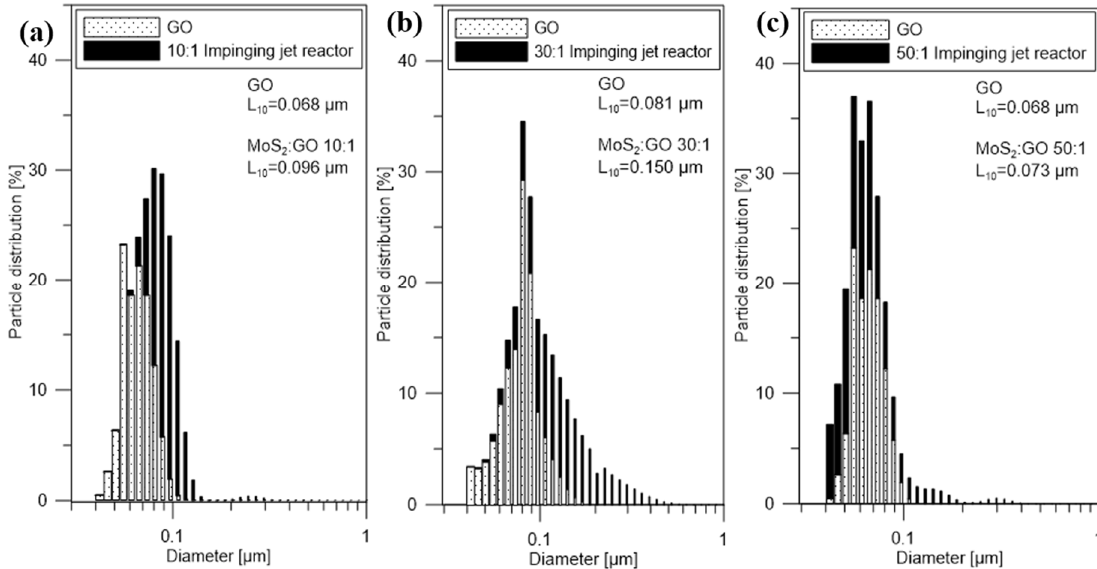
Figure 4. Particle size distribution profiles by number of particles of direct products of the reaction in the impinging jet reactor for MoS 2 /GO ratio ( a ) 10:1 ( b ) 30:1 ( c ) 50:1 and GO just before the reaction. the impinging jet reactor for MoS 2 / GO ratio ( a ) 10:1 ( b ) 30:1 ( c ) 50:1 and GO just before the